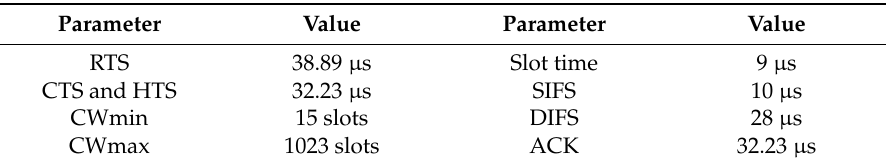
Table 4. Simulation parameters of IEEE